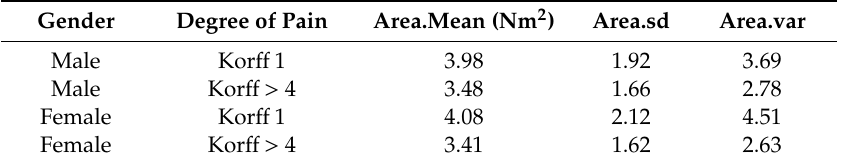
Table 4. Overview of the results of the PSD analysis separated by gender and degree of pain.